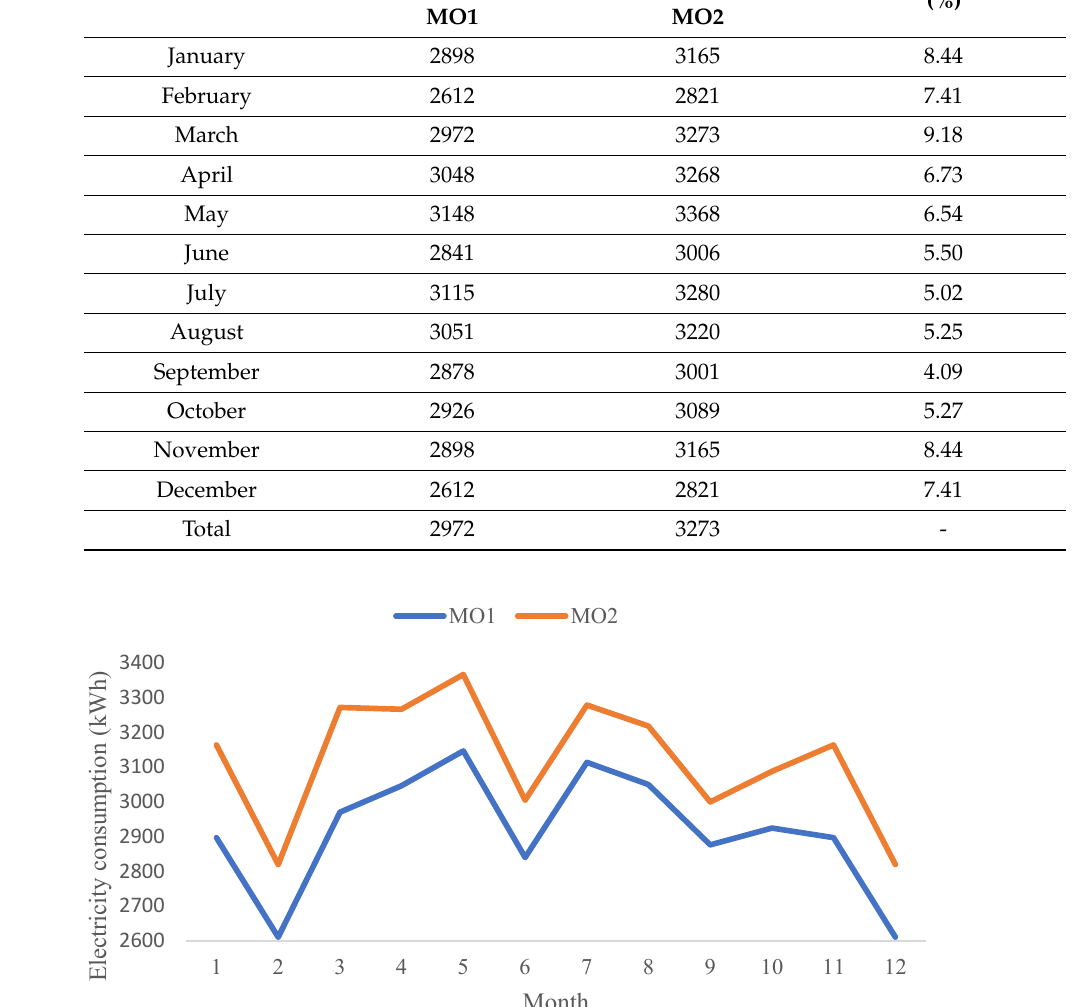
Figure 11. Comparison of current consumption due to air conditioning for the previous study (MO1) and the current one (MO2).